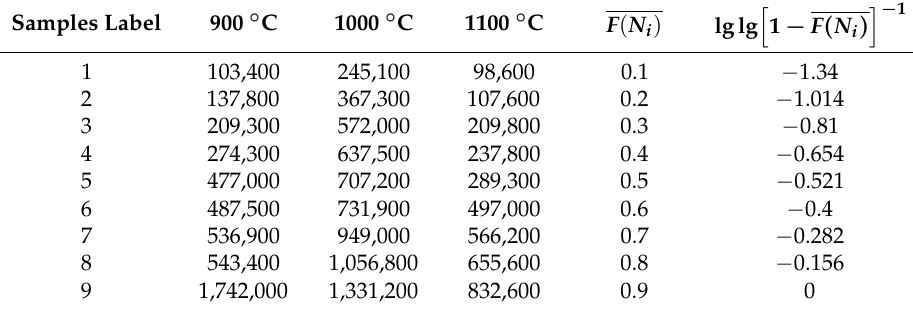
Table 3. Detail result of test date steel.